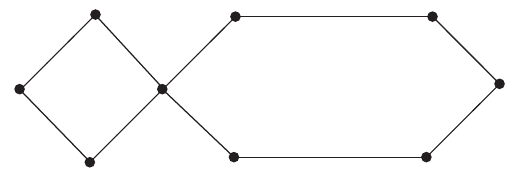
Figure 2: A group G for which R c ( G ) + 1. ( 1/2 )